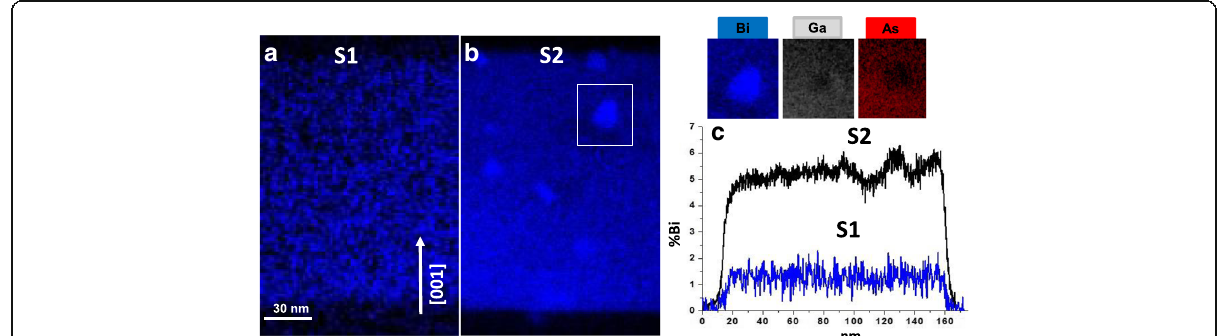
Fig. 2 STEM/EDX elemental maps representing Bi distribution in samples S1 ( a ) and S2 ( b ). Details of Bi, Ga and As elemental maps corresponding to the cluster marked with a white rectangle in Fig. 1b reveal a drop in As and Ga signals where there is a high Bi region. c Bi content profiles along [001] direction extracted after integration of an area of around 130 nm from the EDX map of samples S1 (blue line) and S2 (black line). Similar features were observed in the intensity profiles at low magnification shown in Fig. 1c